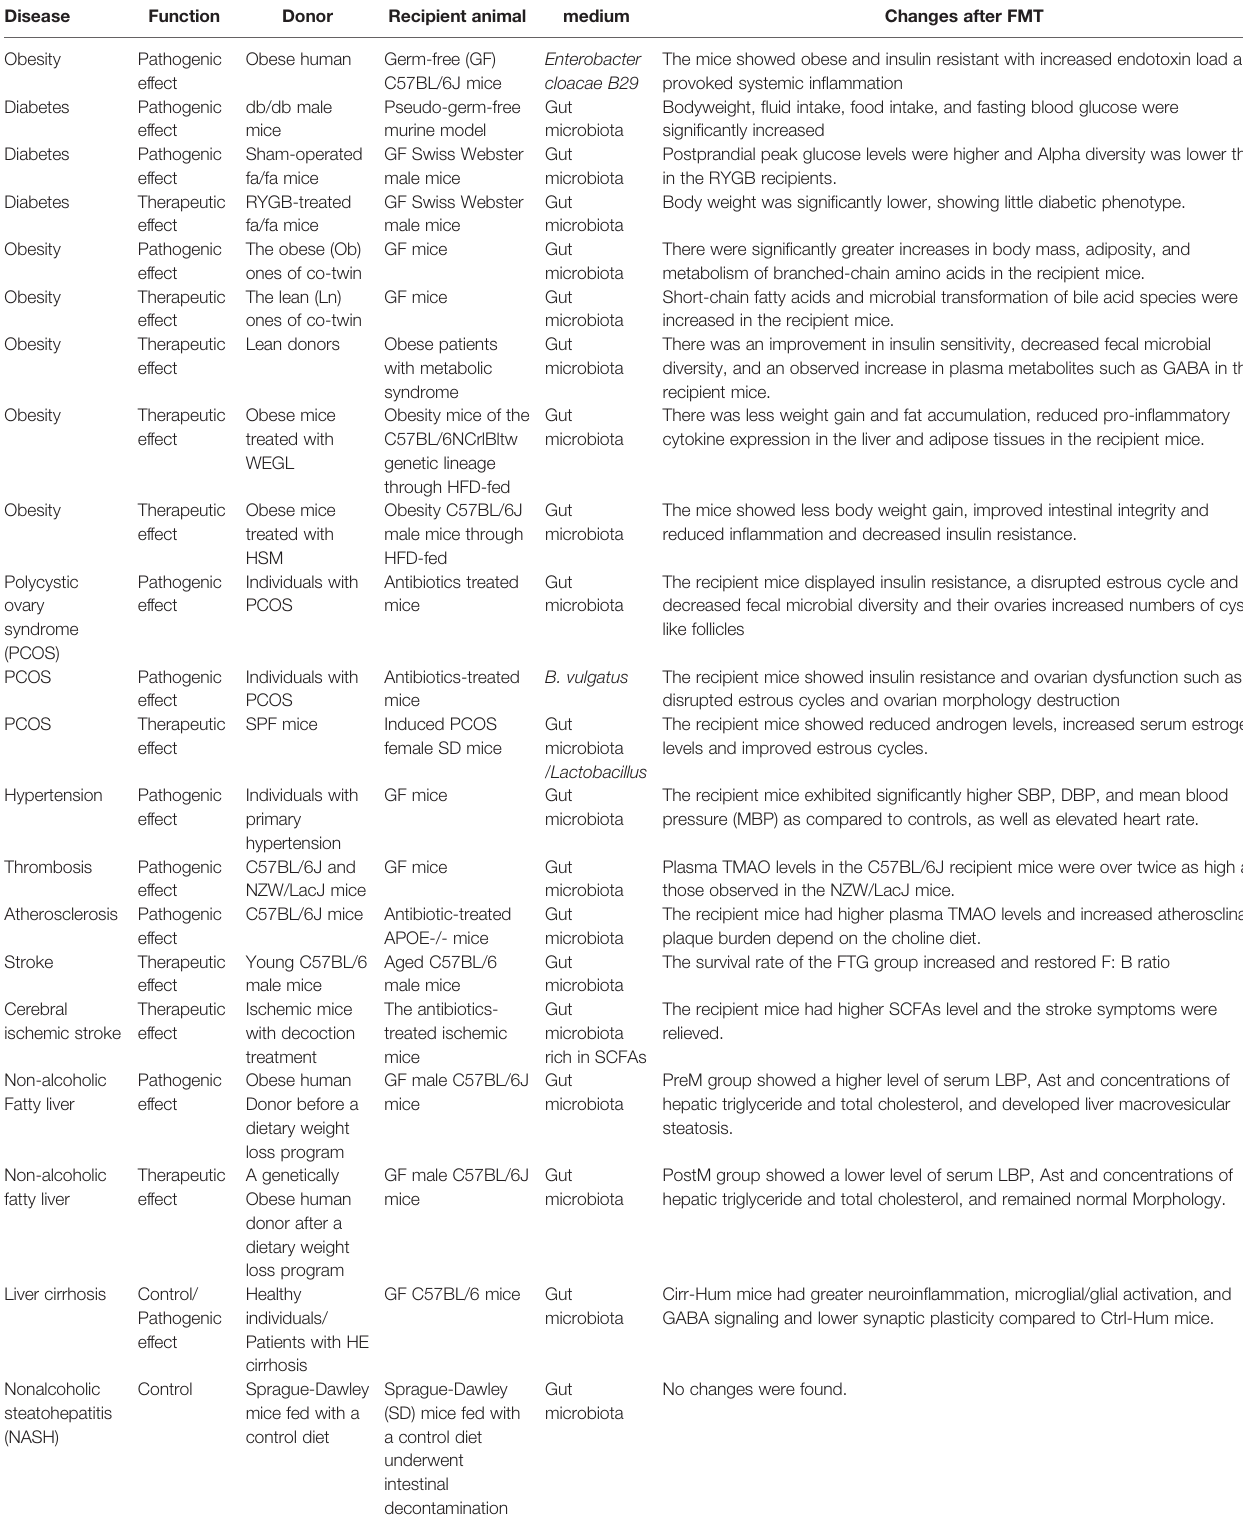
TABLE 1 | The role of gut microbiota as a transmission in different diseases.